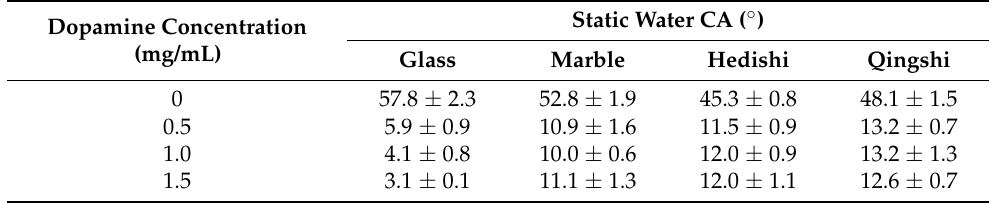
Table 1. Variation of static water CAs on blank and PDA-covered glass and stone surfaces as a function of dopamine concentration in Tris-HCl